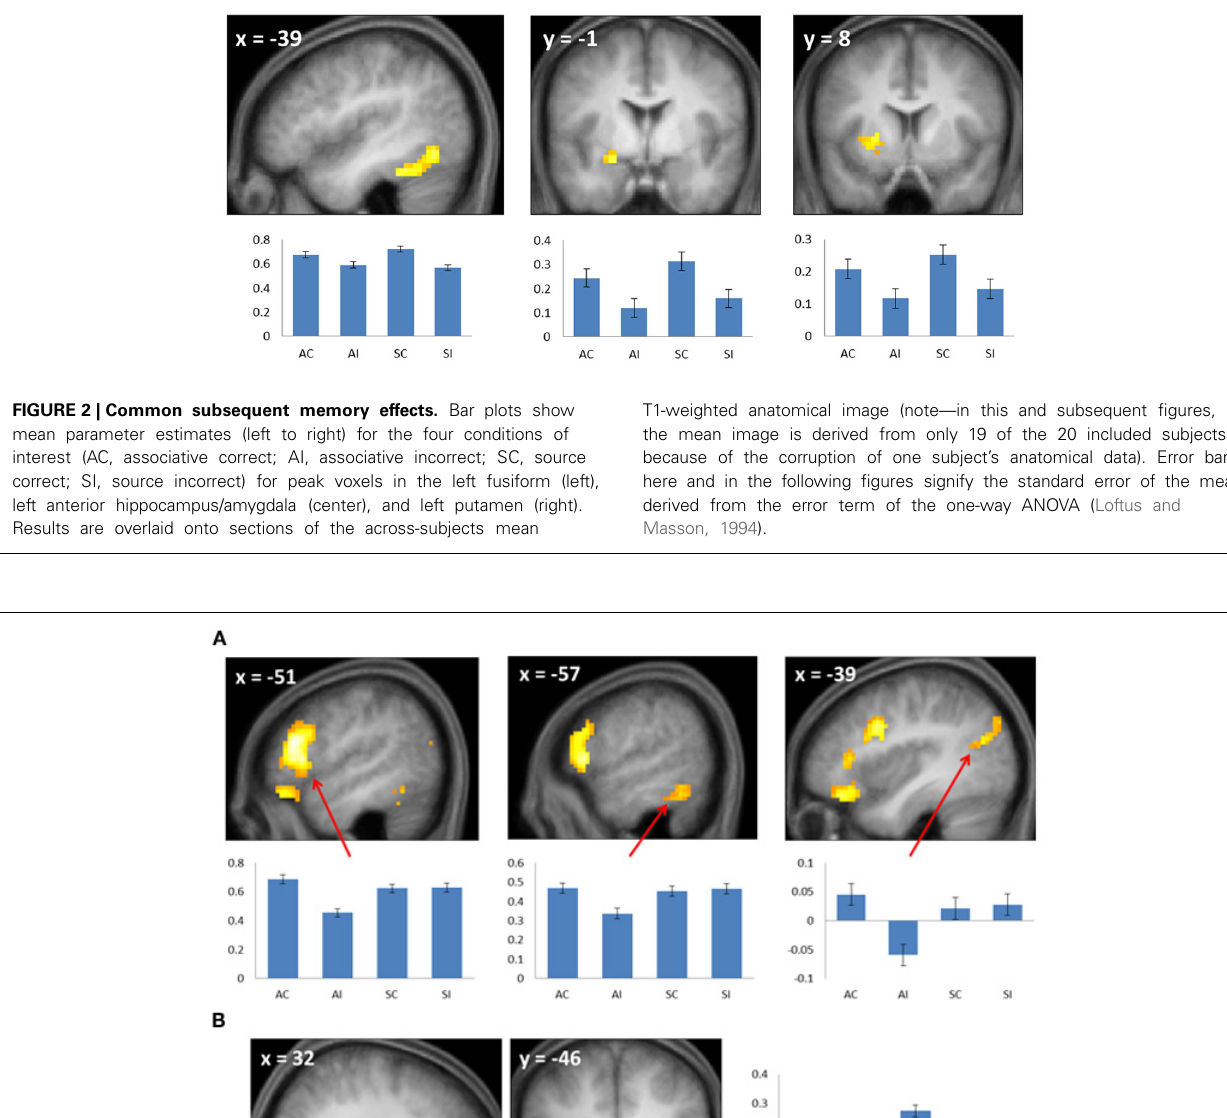
FIGURE 3 | (A) Subsequent associative memory effects. Bar plots show (left to right) mean parameter estimates for the four conditions of interest for peak voxels (arrows) in LIFG, left inferior temporal gyrus, and left angular gyrus. (B) Subsequent source memory effect in the right